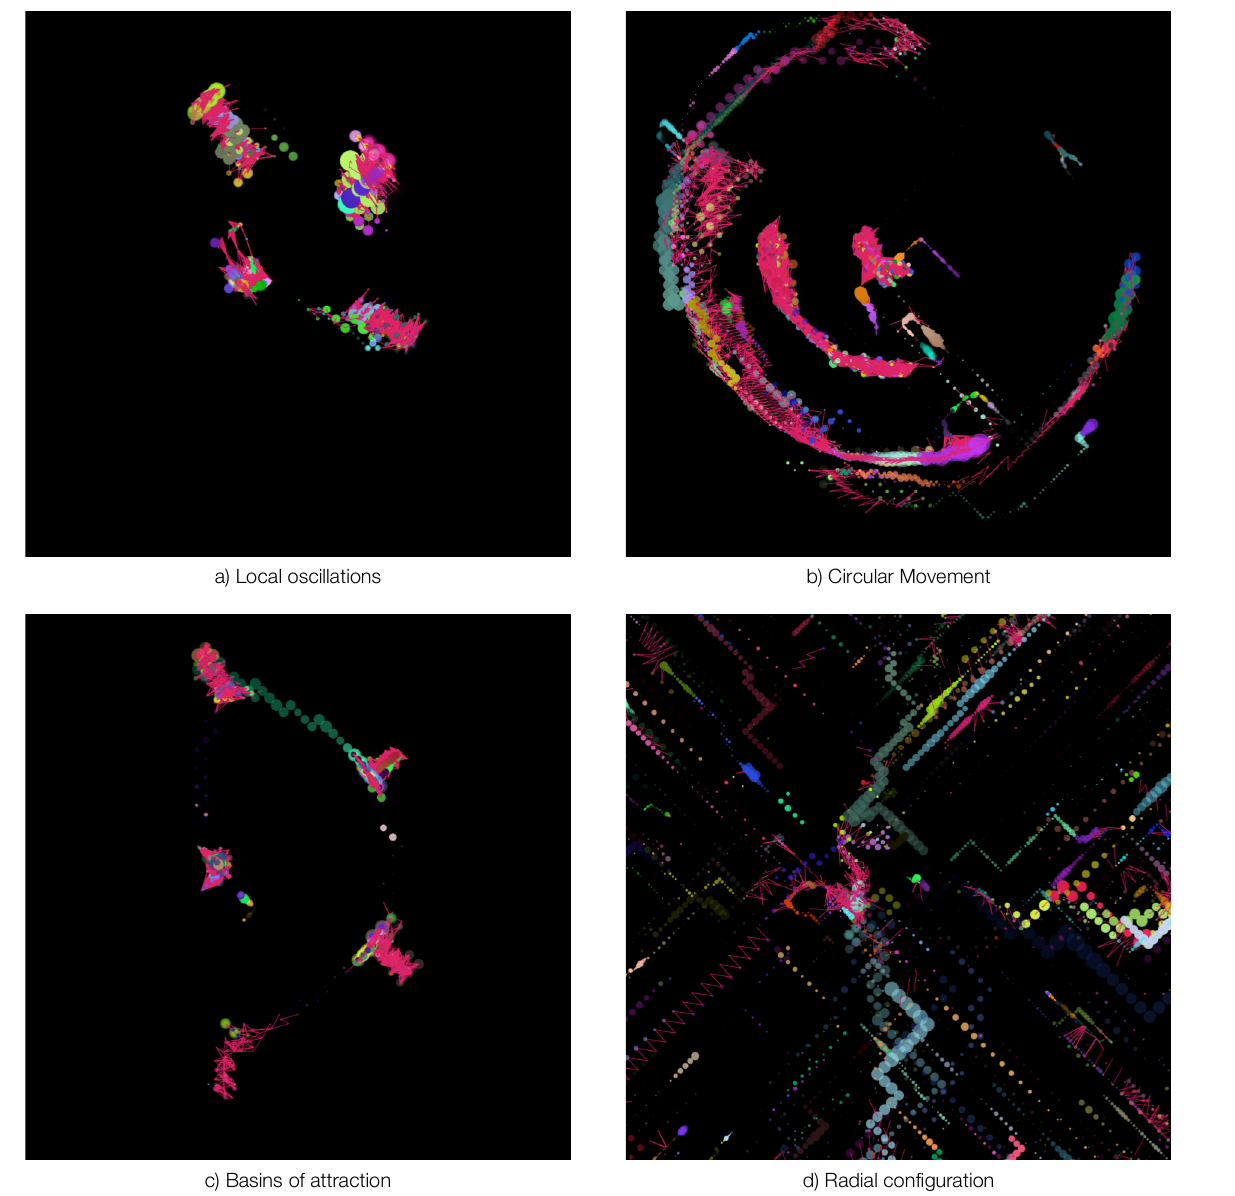
Figure 2 | Spatial configurations resulting from different settings for the Actors